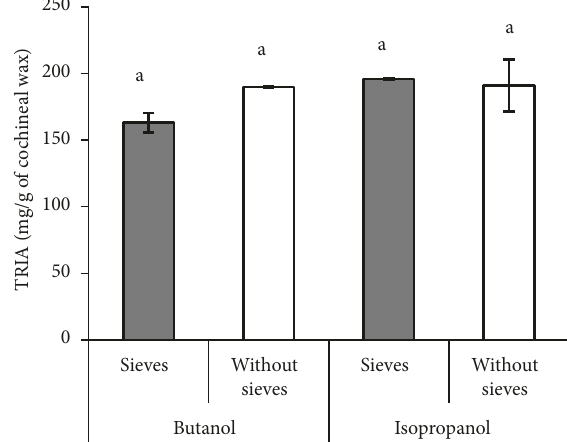
Figure 7: Effect of molecular sieves on triacontanol (TRIA) content obtained in transesterification reactions with butanol and iso- propanol as acyl receptors in toluene medium using orbital agi- tation ( P < 0 . 05;